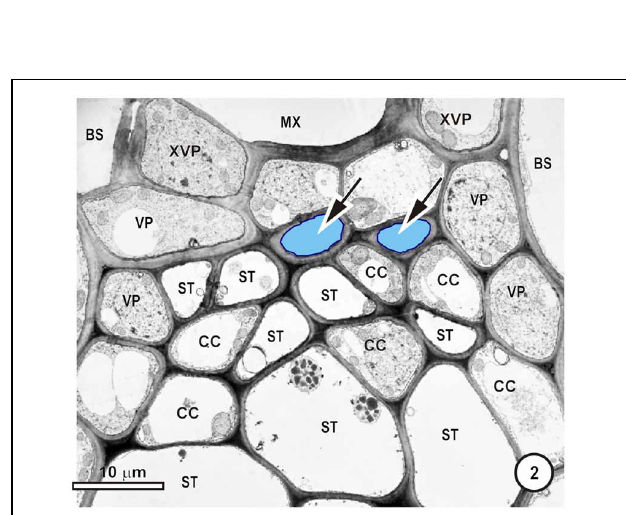
FIGURE 2 | Detail of the phloem within a large intermediate vascular bundle in the rice leaf blade. Two thick-walled (TSTs, arrows, blue outline, pale blue fill) and numerous thin-walled (STs) sieve tubes are visible. All STs are associated with companion cells (CC, not all are labeled) and surrounding the ST-CC’s are peripherally-located vascular parenchyma (VP), external to which is the bundle sheath (BS). Note that the lower ST are larger than the upper